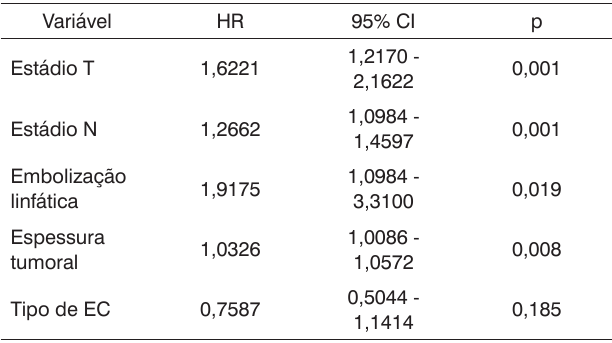
Tabela 6. Fatores estaticamente significativos, em análise multivaria- da, para a sobrevida